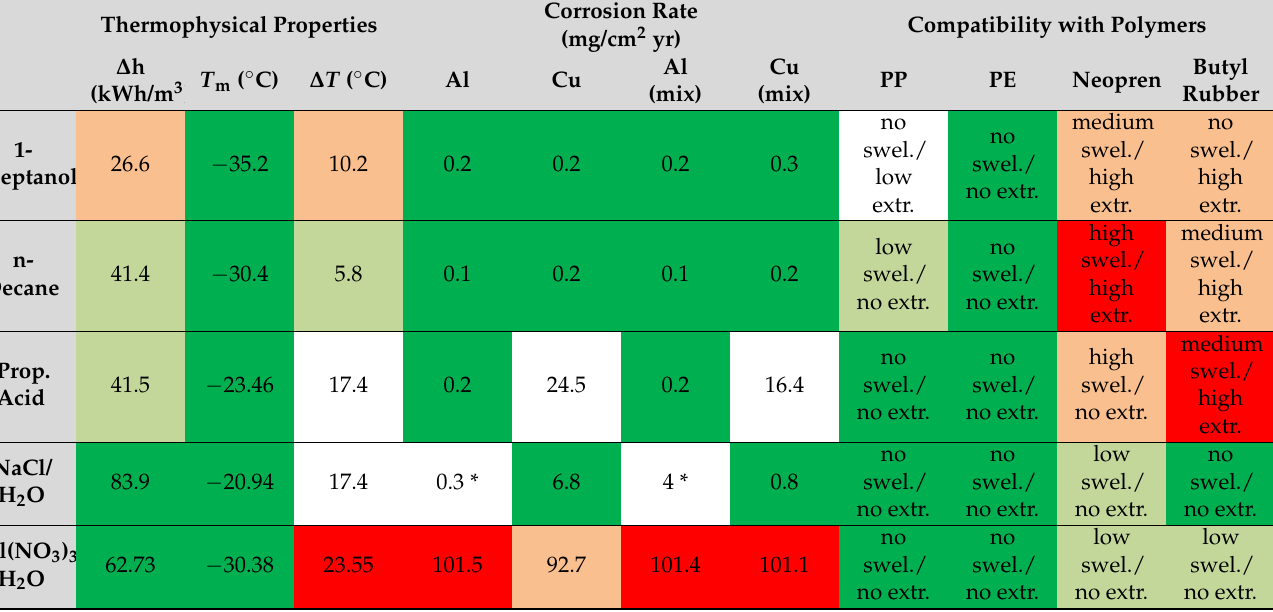
Table 7. Summary of PCM properties determined in the framework of this project. The cell color indicates the suitability of each determined property for an application in a latent heat storage unit. Red: not suitable; orange: possibly not suitable; white: suitable under restrictions; light green: suitable with good performance; dark green: suitable with very good performance. The values reported here are mean values. The standard deviations are reported in previous